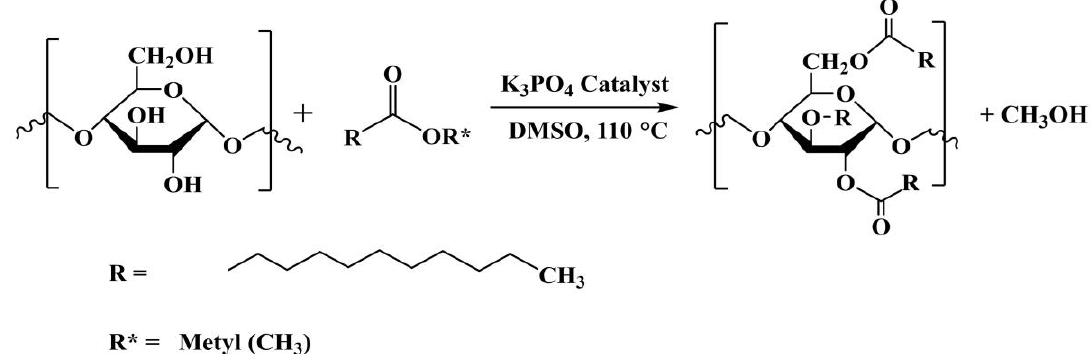
Figure 1. Transesterification of starch and methyl laurate.